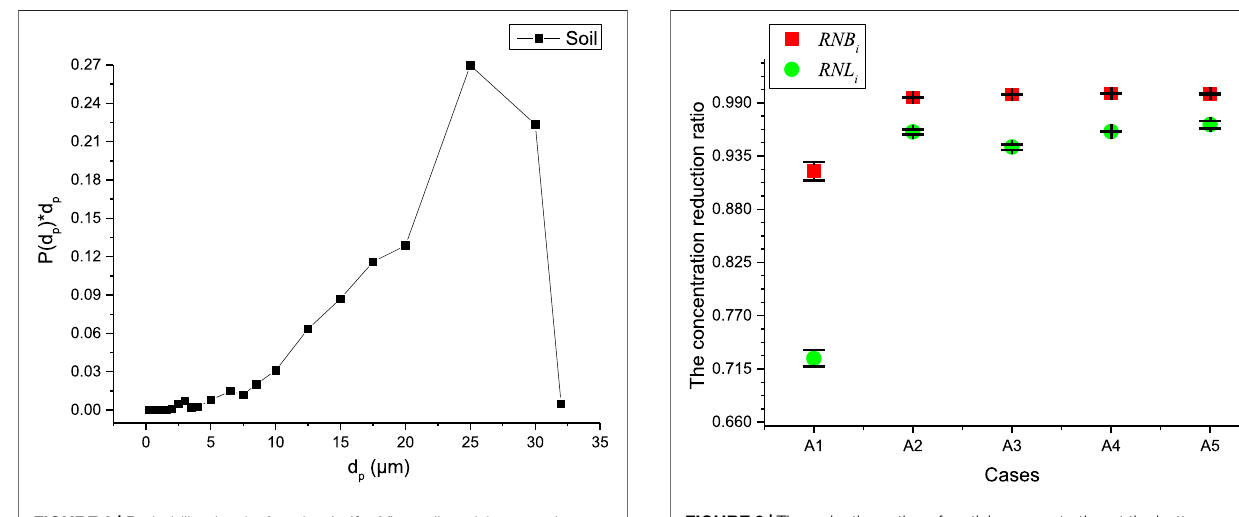
FIGURE 8 | Probability density function (pdf) of fi ne soil particles tested with Grimm Probe A in A1 case (particle diameter/pdf).